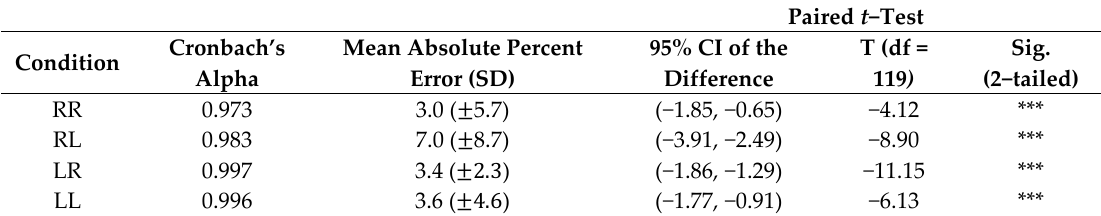
Table 1. Validity statistics by condition, Cronbach’s alpha, mean absolute percent error (SD), and paired t